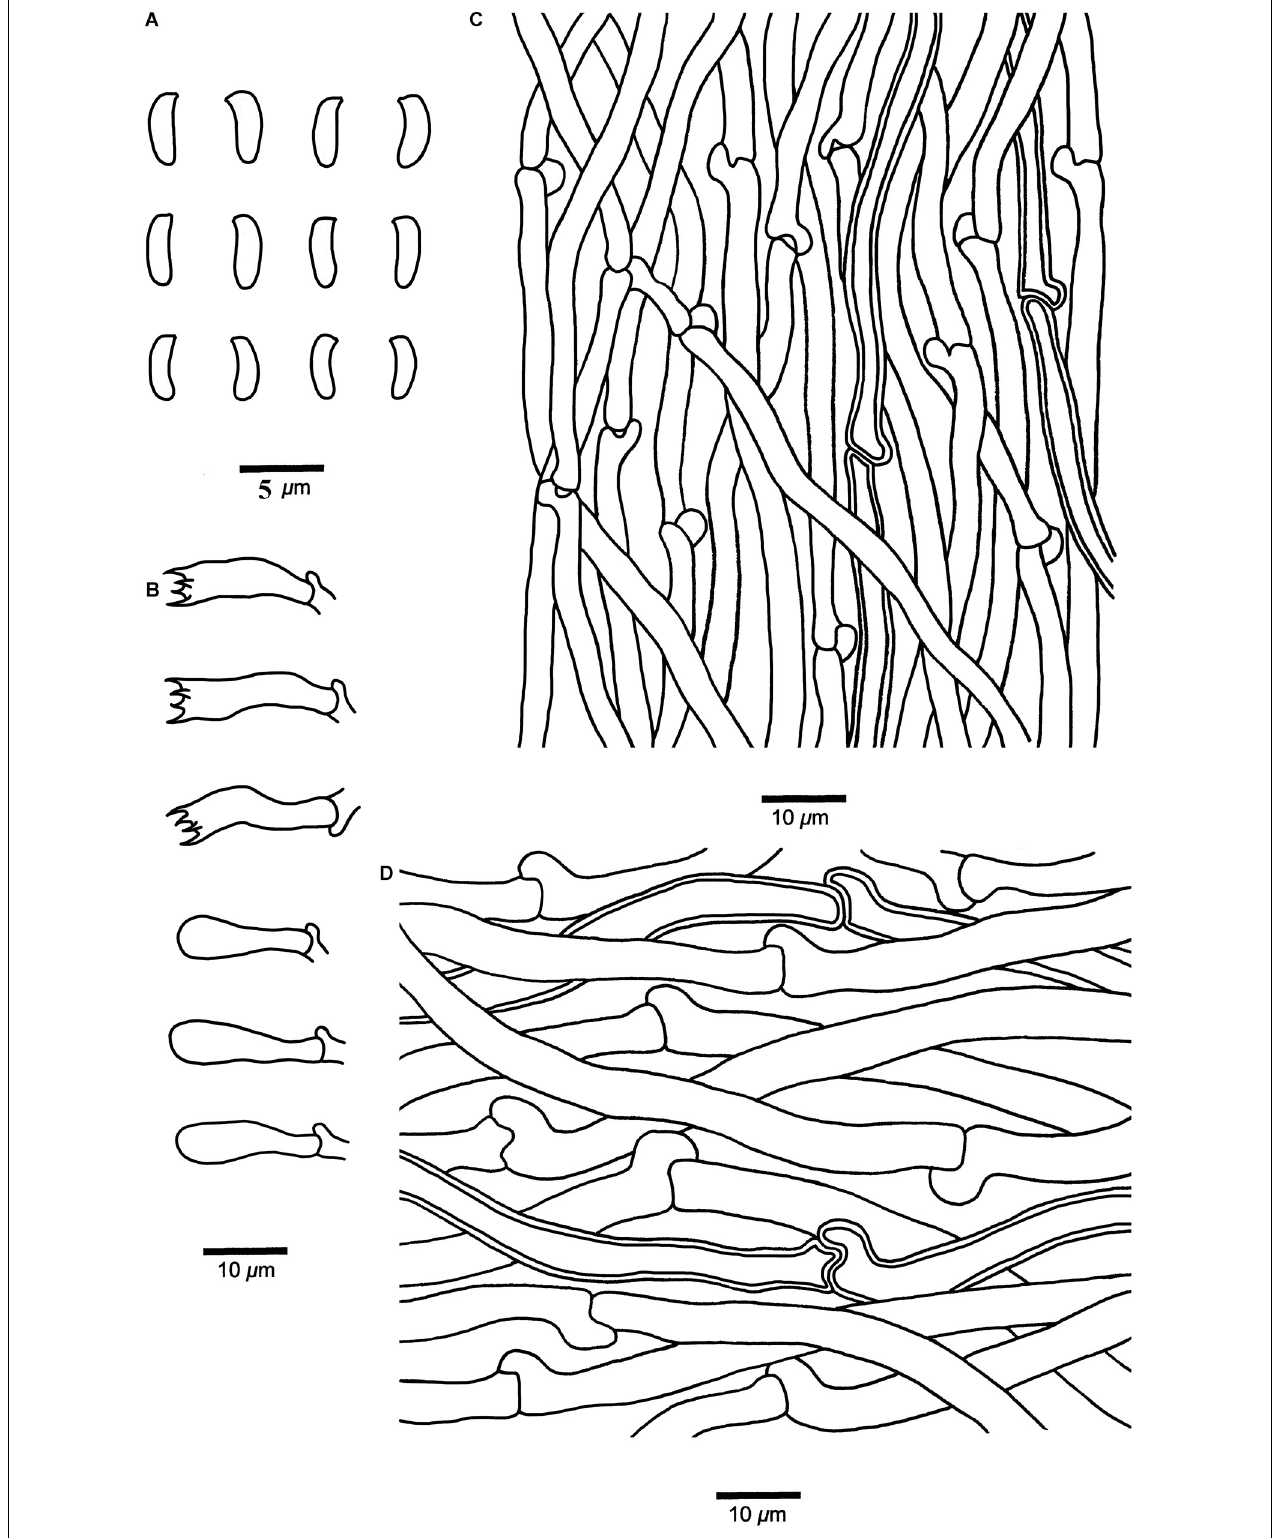
FIGURE 8 | Microscopic structures of Cyanosporus submicroporus (drawn from the holotype). (A) Basidiospores; (B) Basidia and basidioles; (C) . Hyphae from trama; (D) Hyphae from context. Bars: (A) = 5 µ m; (B–D) = 10 µ m.